Question: What form of chart is displayed?
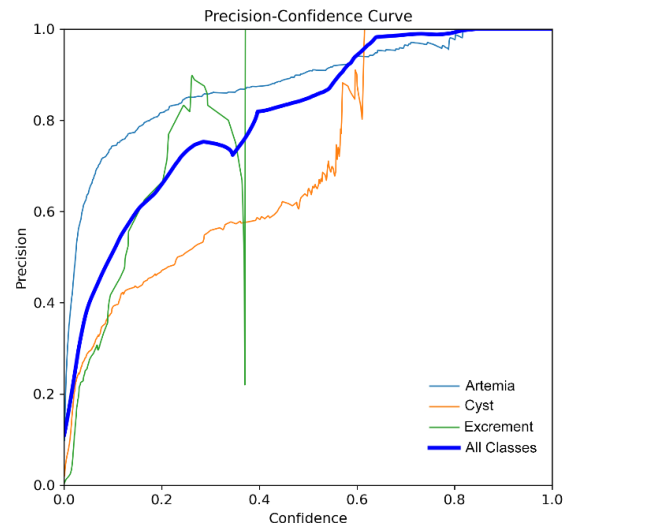
Answer: line